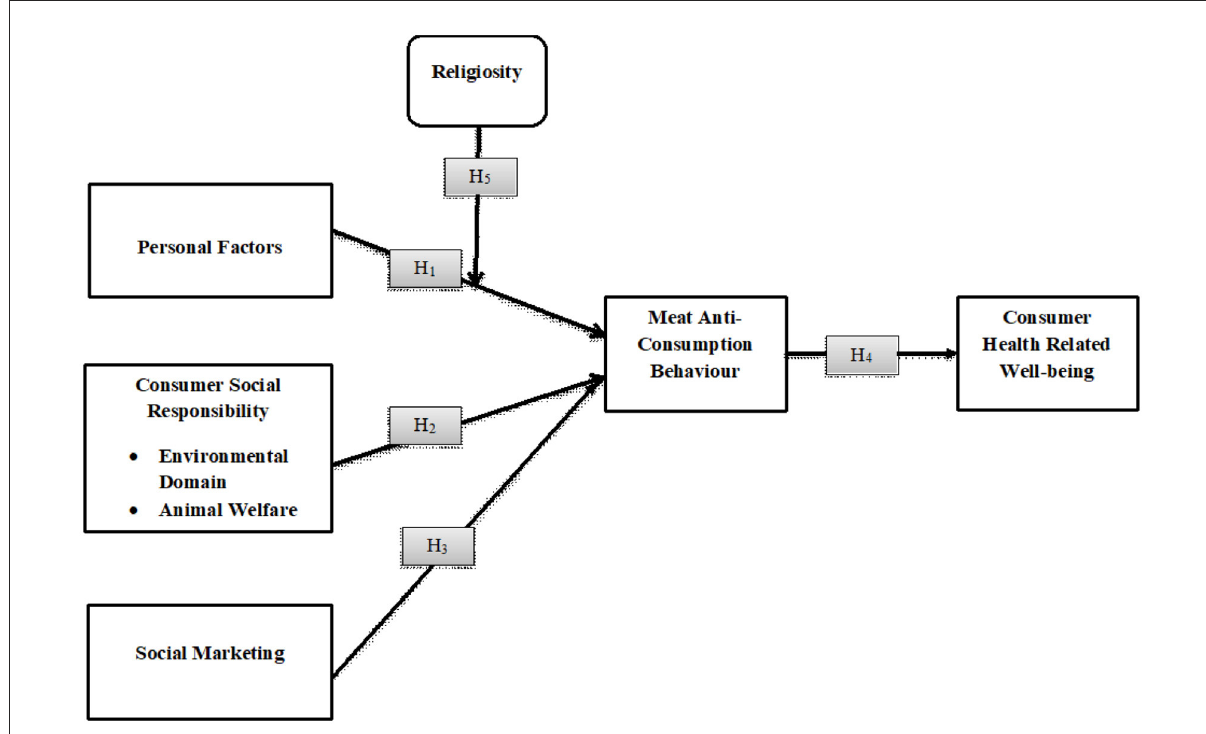
FIGURE1 Theoretical